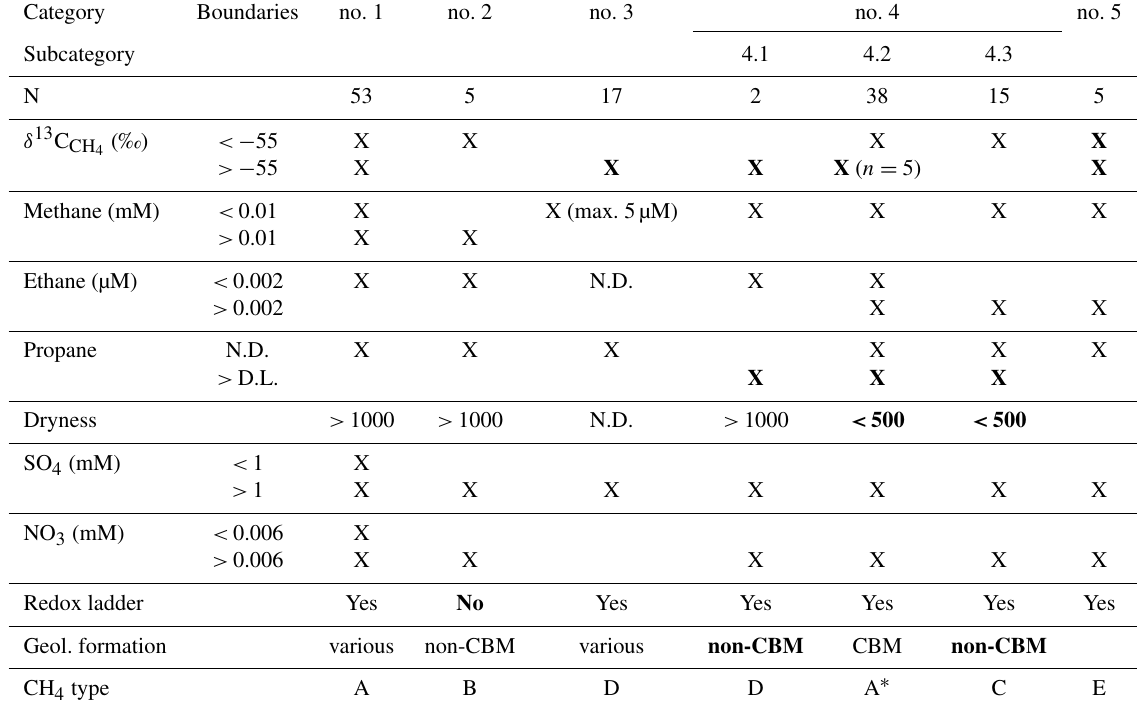
Table 3. Categories classification, boundaries and methane type (values in boldface indicate anomalies, N.D.: non-detected, D.L.: detection